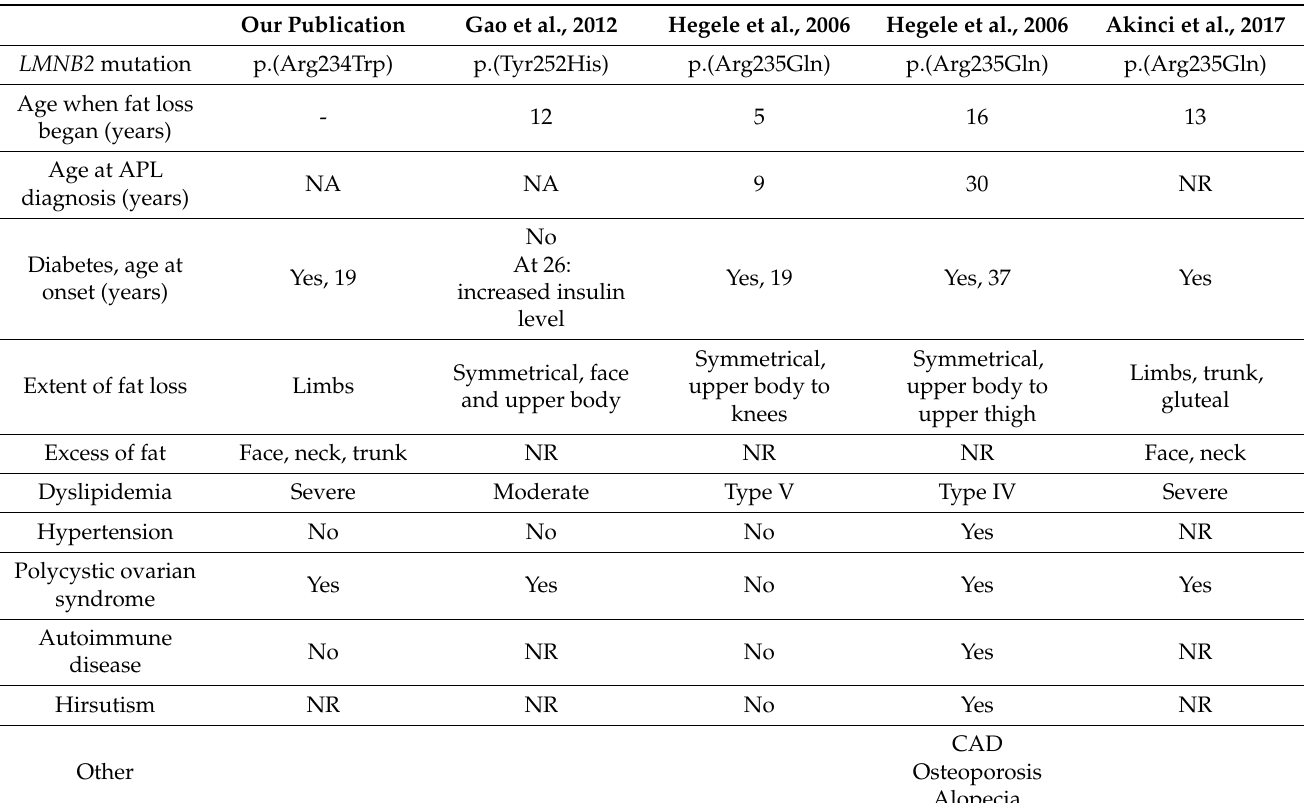
Table 2. Clinical features of subjects with lipodystrophy and rare LMNB2 mutations annotated according to the transcript NM_032737.4 (NA: not applicable, NR: not